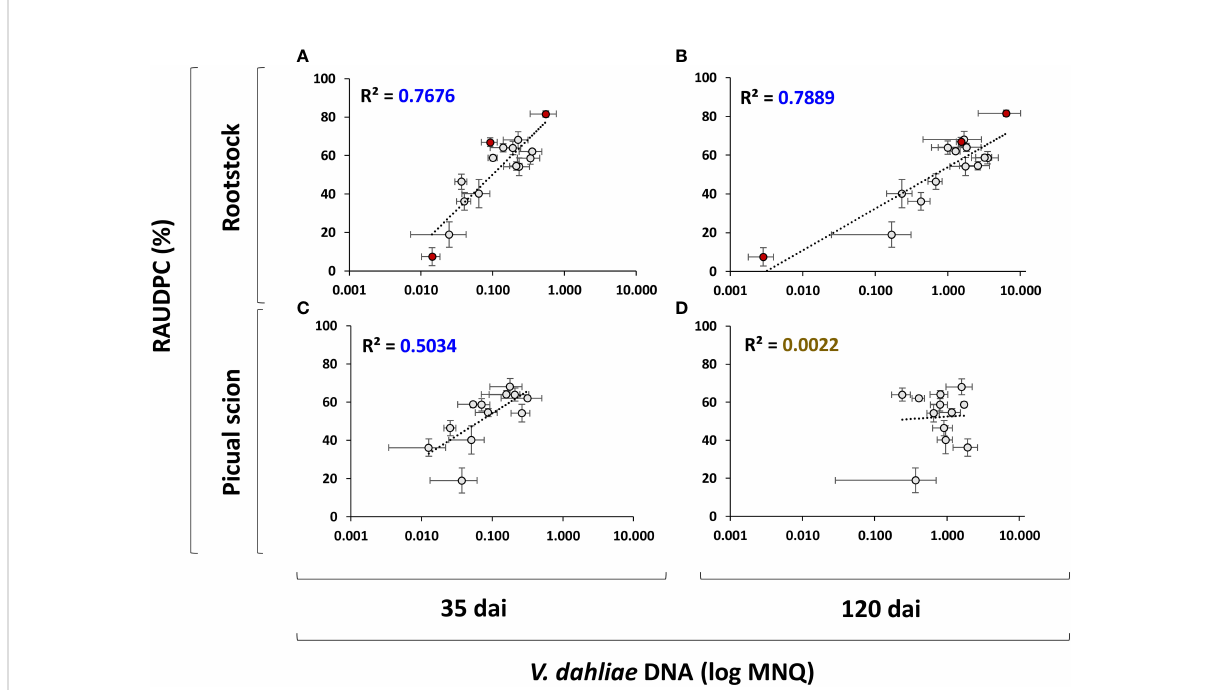
FIGURE 5 Scatter plots including regression line and coef fi cient of determination (R 2 ) days after inculation (dai) for the relationships between the RAUDPC and the Mean Normalized Quantity (log MNQ) of Verticillium dahliae DNA in rootstock trunks at 35 dai (A) and 120 dai (B) , and in the 'Picual' scions at days after inculation 35 dai (C) and 120 dai (D) . Results are the mean of 16 plants. Red points indicate non-grafted ‘ Frantoio ’ , ‘ Arbequina ’ and ‘ Picual ’ plants. Error bars in two dimensions indicate the standard error of the